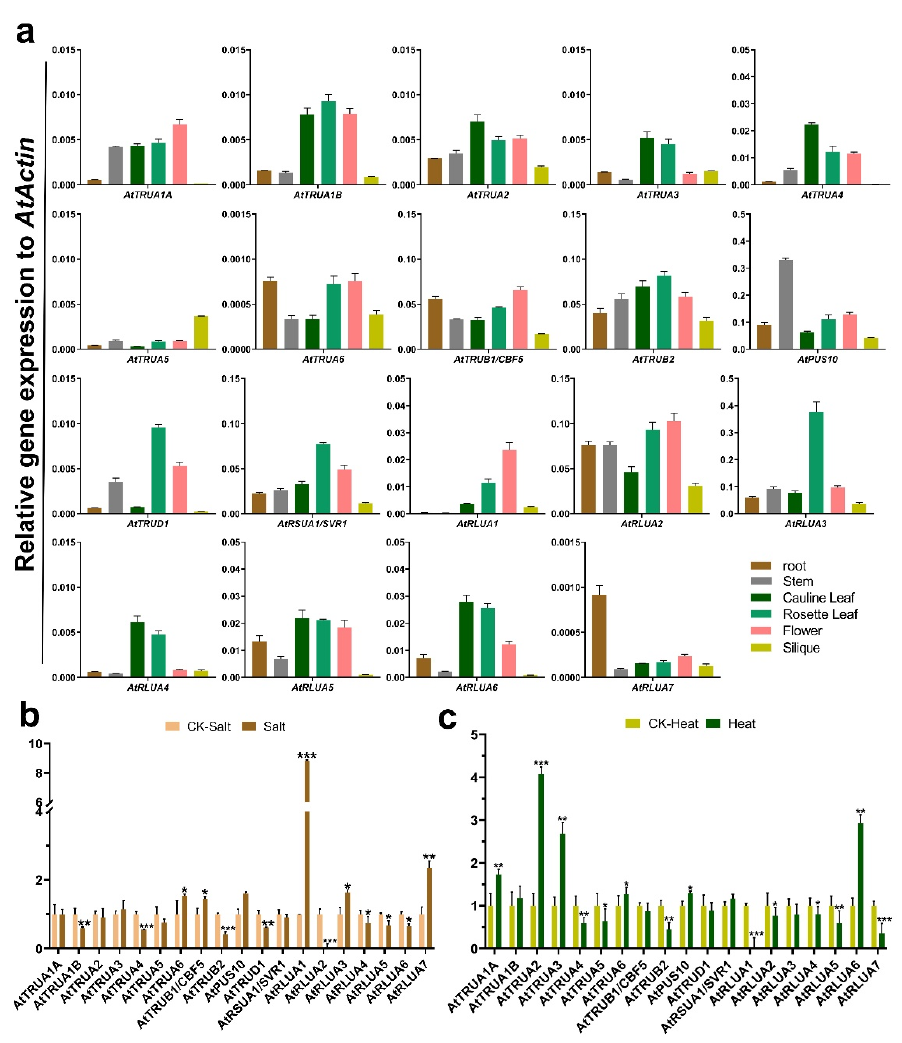
Figure 7. Expression profiles of AtPUS genes in different tissues/organs and in response to abiotic stresses. ( a ) Quantitative real-time PCR for AtPUS genes in different tissues/organs. The y axis indicated the relative expression value to AtActin . ( b ) Quantitative real-time PCR for AtPUS genes in salt stress. ( c ) Quantitative real-time PCR for AtPUS genes in heat stresses. The expression of each sample treated by different abiotic stress were normalized by the corresponding control (CK). Student t -test were applied for the significance statistical analysis. The asterisk indicated the significance of difference between the control and stress-treated samples, * p < 0.05, ** p < 0.01, *** p < 0.001. Likewise, to further analyze the expression pattern of ZmPUS genes, the expression pattern of maize tissues/organs (coleoptile, root, internode, leaf, tassel, cob, silk) at differ- ent developmental stages and maize seedlings with salt and heat stress treatments were also investigated by qRT-PCR analysis (Figure 8). In line with the observation in the ex- pression of AtPUS s, there’s no consistent expression pattern even in each of ZmPUS sub- families. The expression levels of most of ZmPUS genes were relatively high in leaf, inter- node, and cob. In particular, ZmTRUA3 , ZmTRUD1 , and ZmRLUA4 have the highest ex- pression level in cob, whereas ZmTRUA5 largely expressed in internode and silk (Figure 8a). Under salt stress, ZmTRUA1 , ZmTRUA5 , ZmTRUA6, ZmTRUD2 , ZmTRUB1B , ZmTRUB2 , ZmRLUA3 , and ZmRLUA4 were highly induced (Figure 8b). Under heat stress, several ZmPUS genes such as ZmTRUB1A/C and ZmRSUA1 were down-regulated, while ZmTRUB1B were moderately up-regulated (Figure 8c).